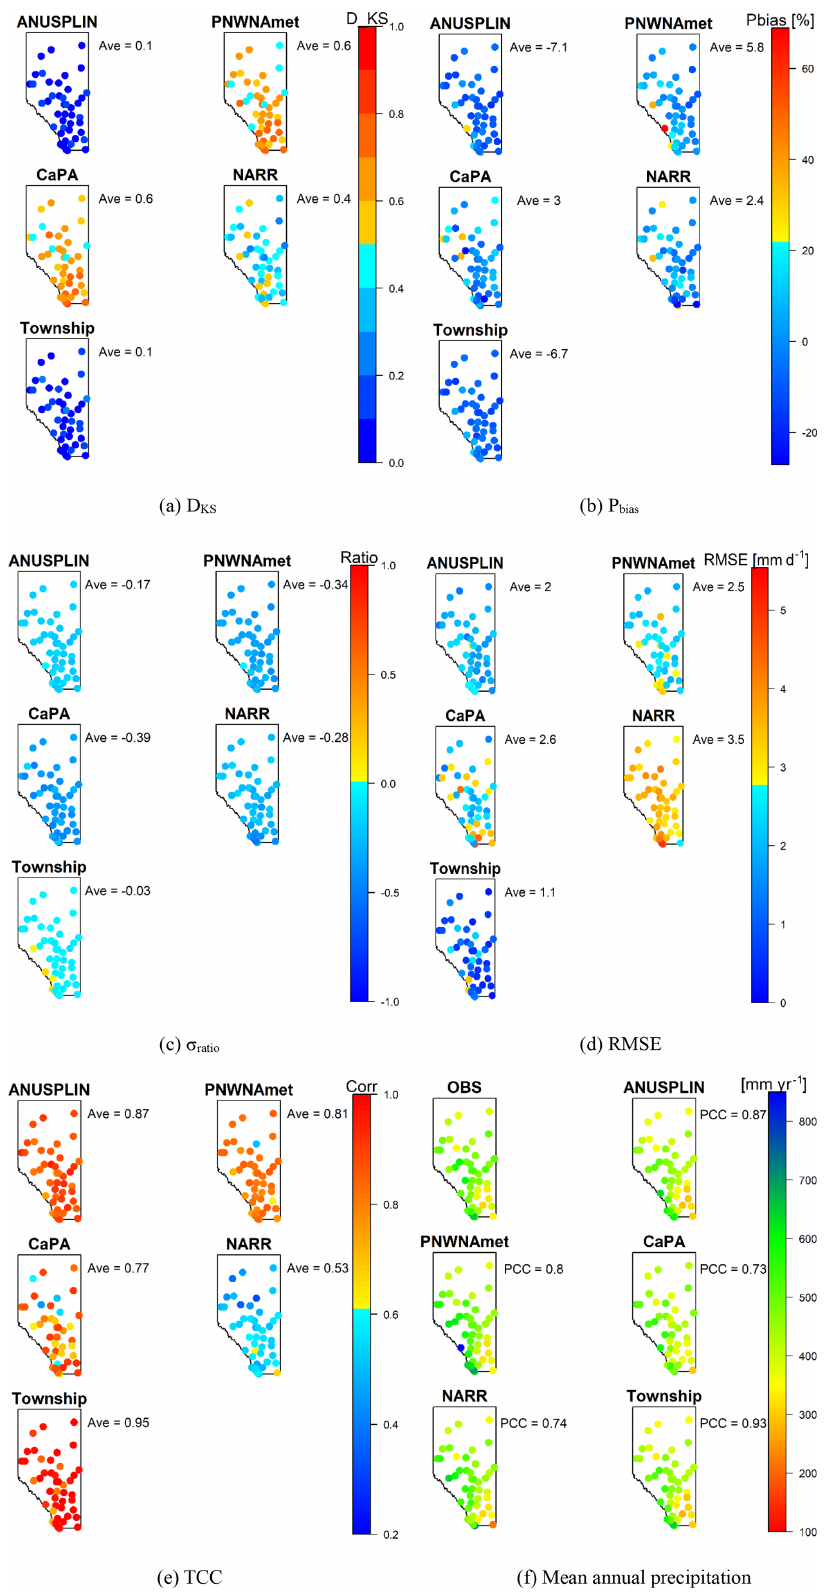
Figure 5. Maps of performance measures for AHCCD precipitation stations in Alberta. (a) D KS , (b) P bias , (c) σ ratio , (d) RMSE, (e) TCC, (f) mean annual